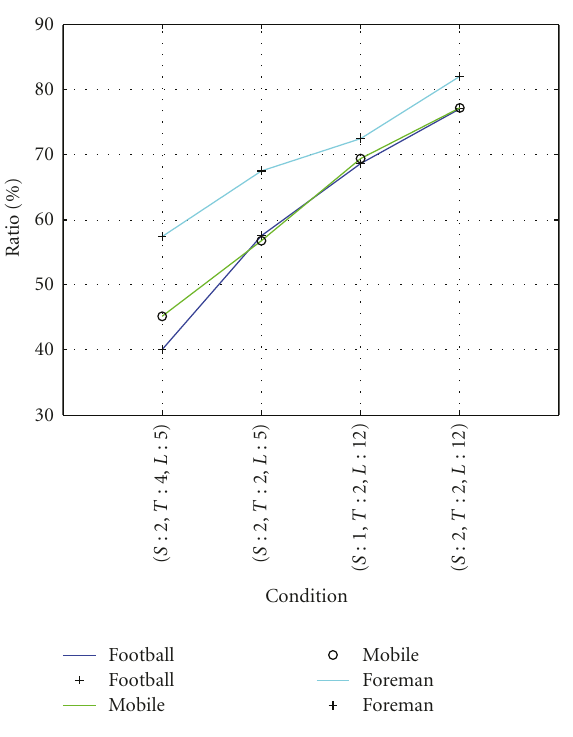
Figure 7: Computation reduction ratio of the proposed